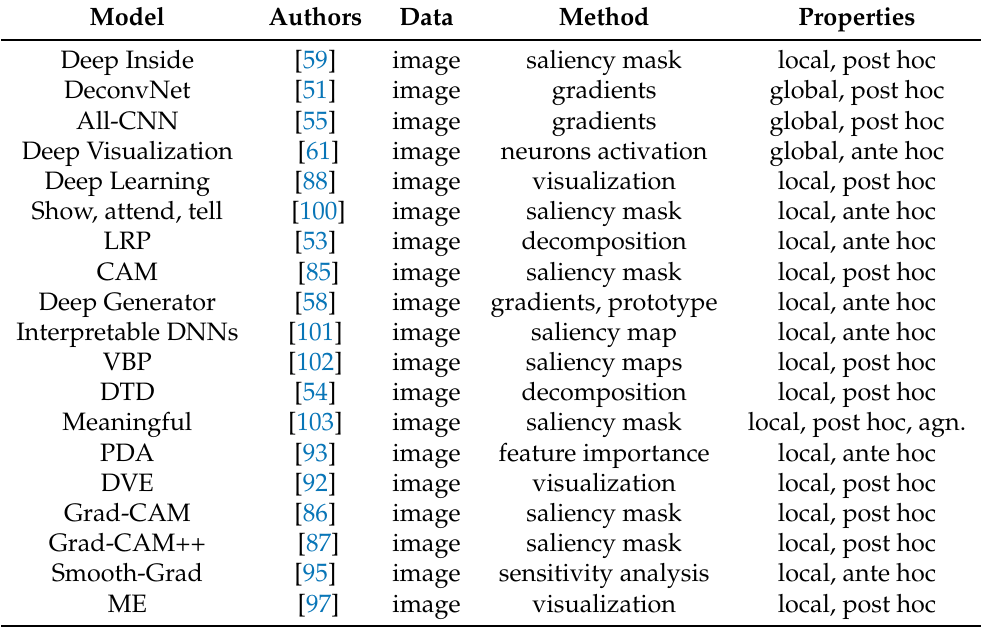
Table 1. Overview of some explainers for DNNs. Ordered by model resp. paper name, reference (author and year), data type, main method, and main